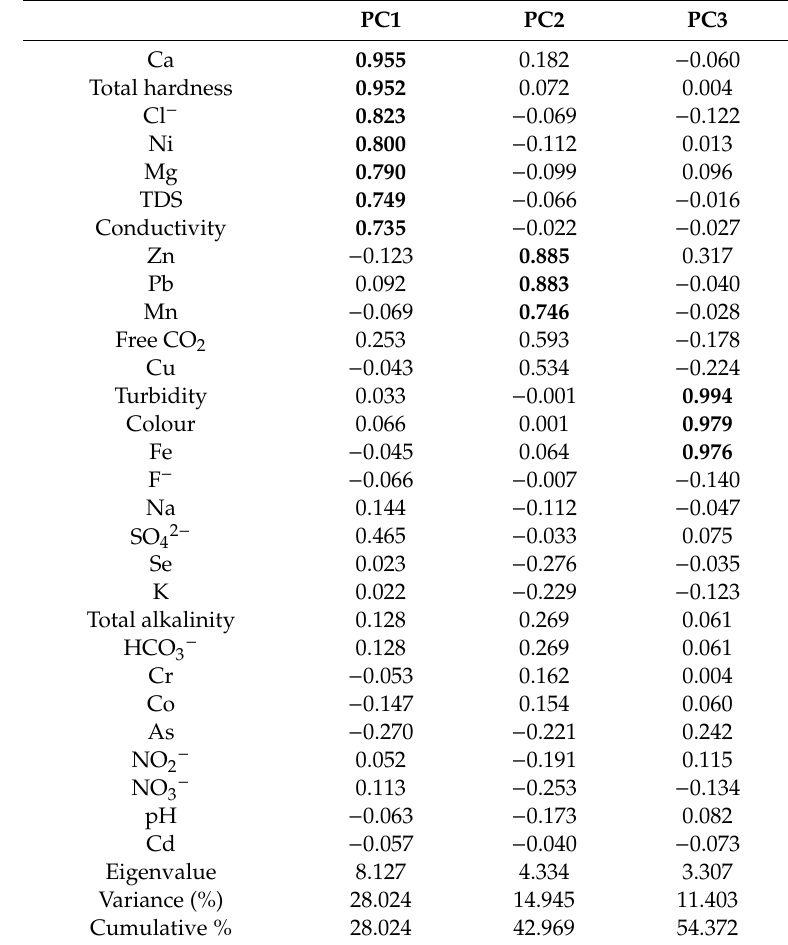
Table 3. Factor loadings of Principal Component Analysis (PCA) for ground and surface water in Makueni County with three factor solutions. The values in bold represent the dominant parameters (with factor loading values greater than